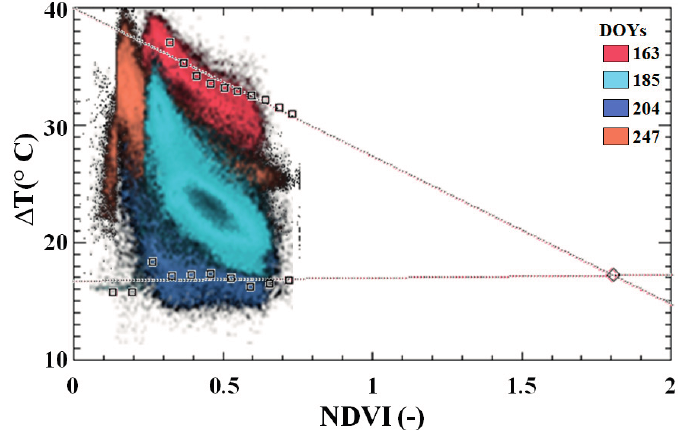
Figure 6. Scatterplot of NDVI vs. Δ T. Over imposed dry ( P max = 97) and wet edges ( P min = 7). Pixels from different images are represented with colours ranging from red to blue, to indicate increasing average θ